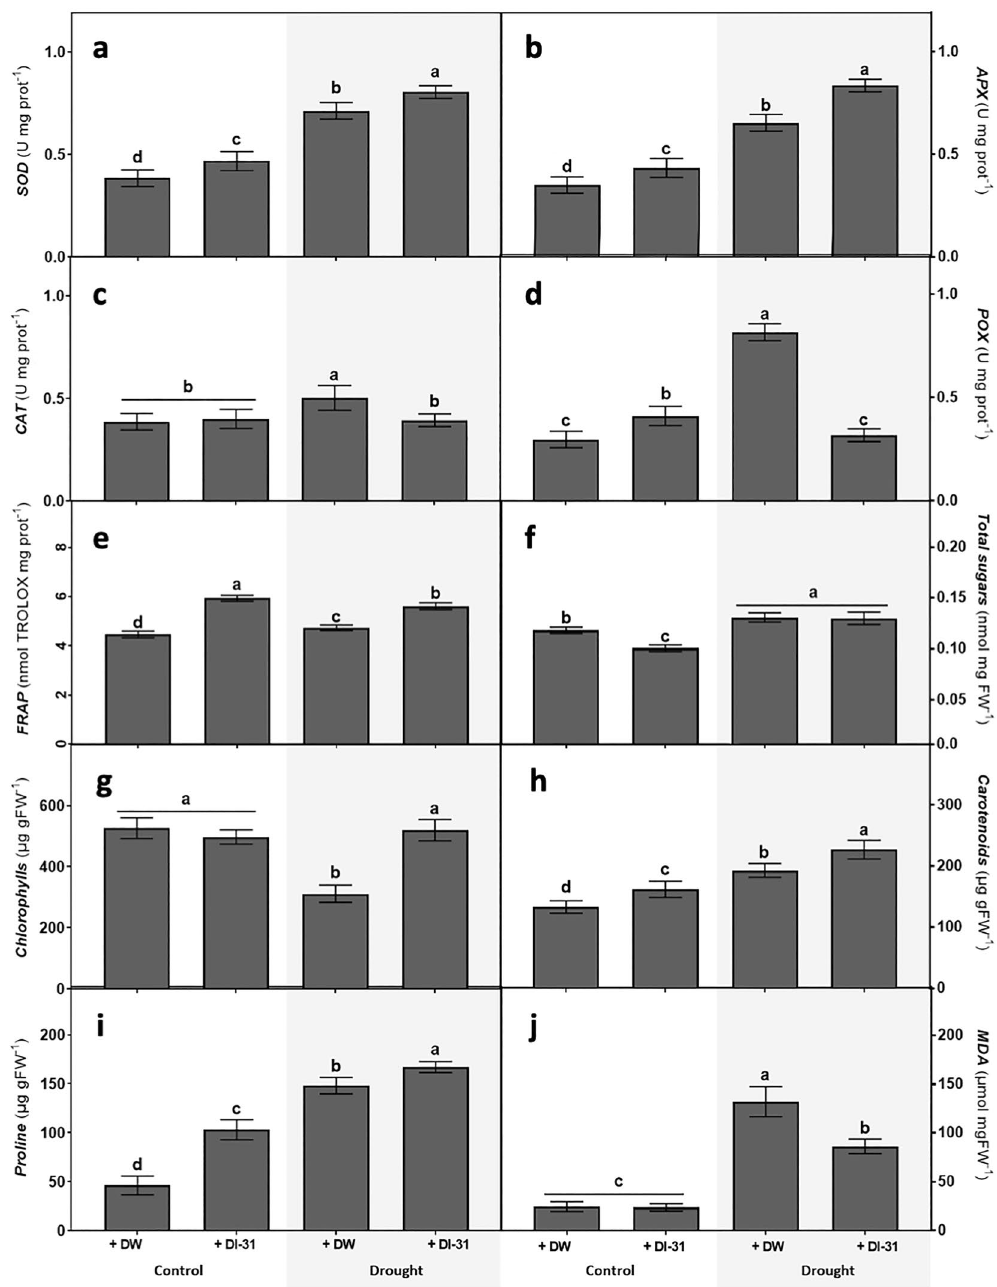
Figure 3. Effect of distilled water (DW) and DI-31 (2.23 µM) foliar applications in soybean stress response. Parameters such as ( a ) superoxide dismutase (SOD), ( b ) ascorbate peroxidase (APX), ( c ) catalase (CAT), ( d ) phenol peroxidase (POX), ( e ) ferric reducing ability potential (FRAP), ( f ) total sugars, ( g ) chlorophylls, ( h ) carotenoids, ( i ) proline and ( j ) malondialdehyde (MDA) content were measured in cv Munasqa plants submitted to well-watered (Ψs = − 0.05 MPa) and drought (Ψs = − 0.65 MPa) conditions for ten days. Data are presented in means ± s.e.m of two independent experiments (n = 120). Different letters indicate significant differences ( P ≤ 0.05) ANOVA with post hoc contrasts by Tukey’s